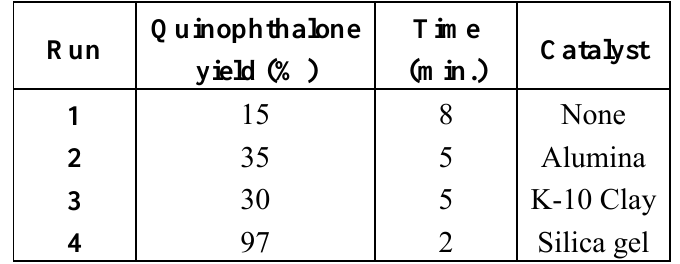
Table 1. Quinophthalone preparation in the presence of different